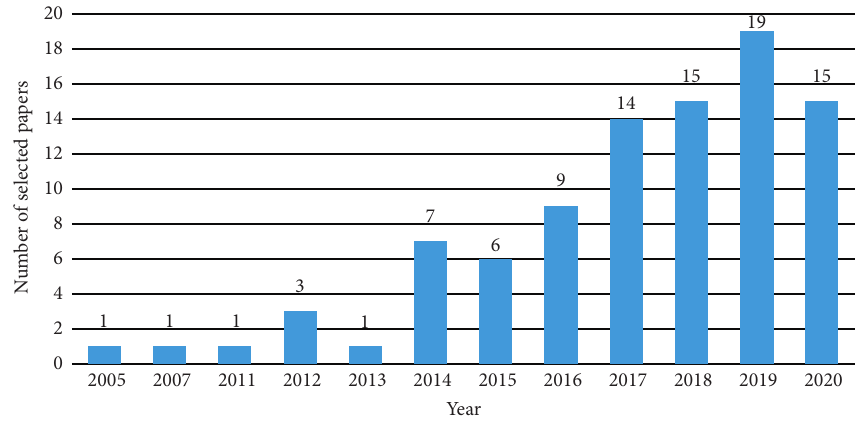
Figure 2: Number of relevant literature studies published yearly from 2005 to